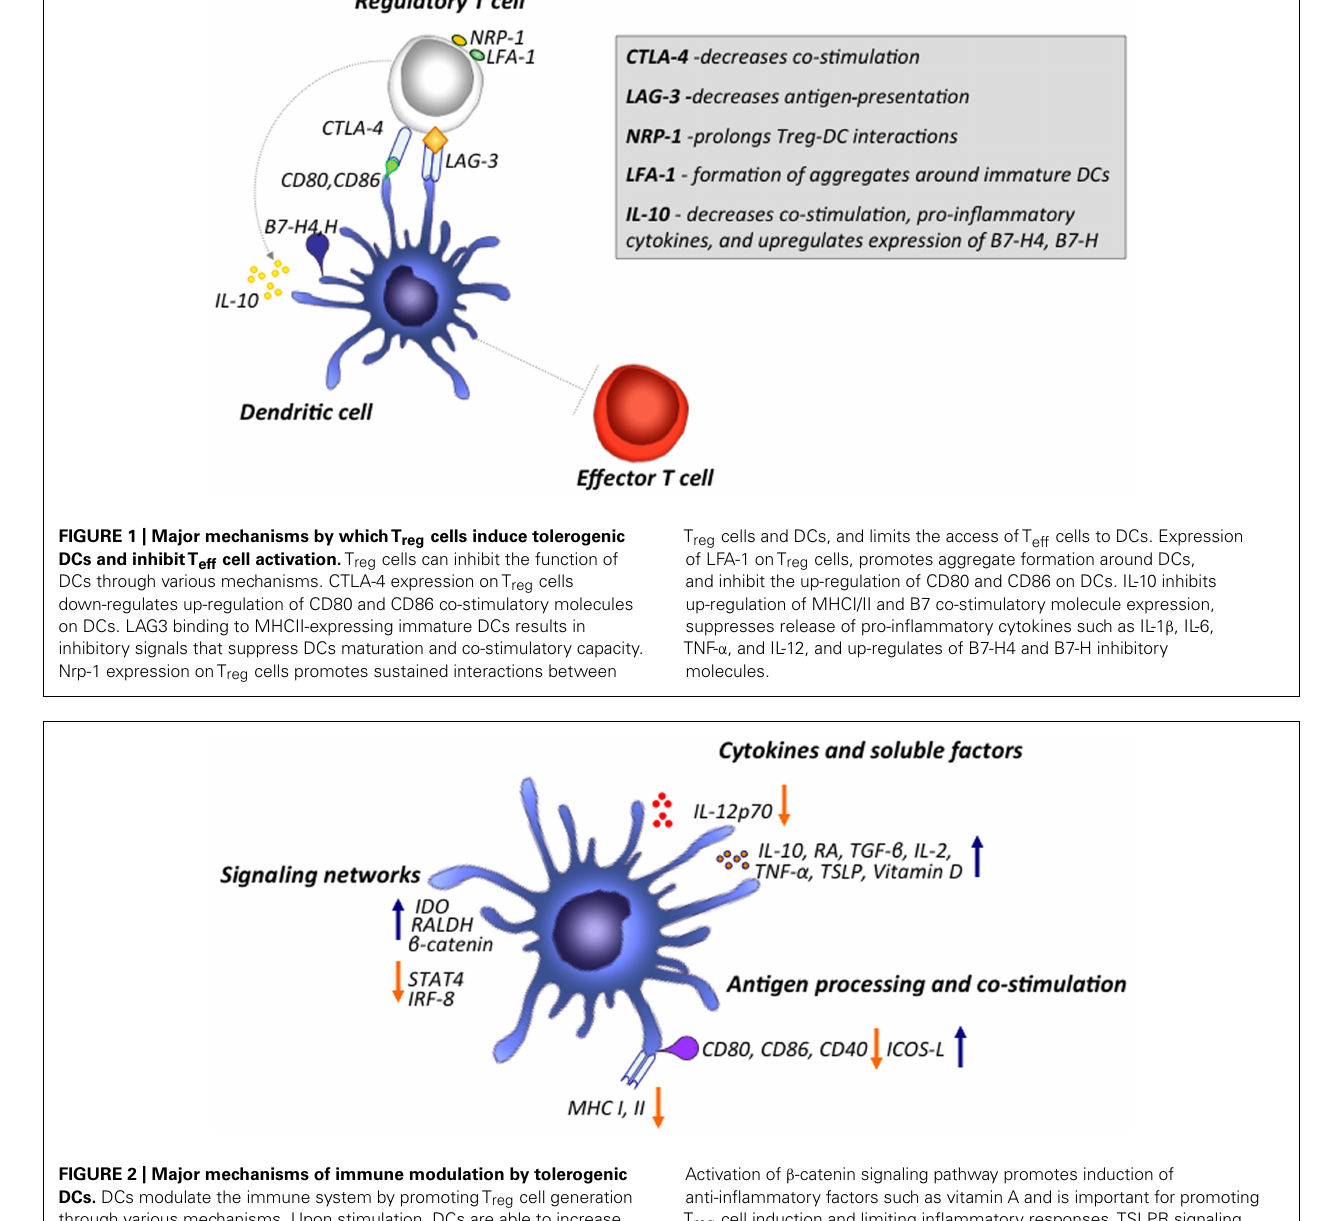
FIGURE 2 | Major mechanisms of immune modulation by tolerogenic DCs. DCs modulate the immune system by promotingT reg cell generation through various mechanisms. Upon stimulation, DCs are able to increase production of various cytokines and inflammatory mediators such as IL-10, RA, vitamin D,TGF- β , IL-2, IL-10,TSLP,TNF- α and down-regulate expression of inflammatory cytokines such as IL-12p70. DCs, by down-regulating co-stimulation and antigen presentation, can favor induction ofT reg cells. Various signaling pathways program DCs to induce tolerogenic